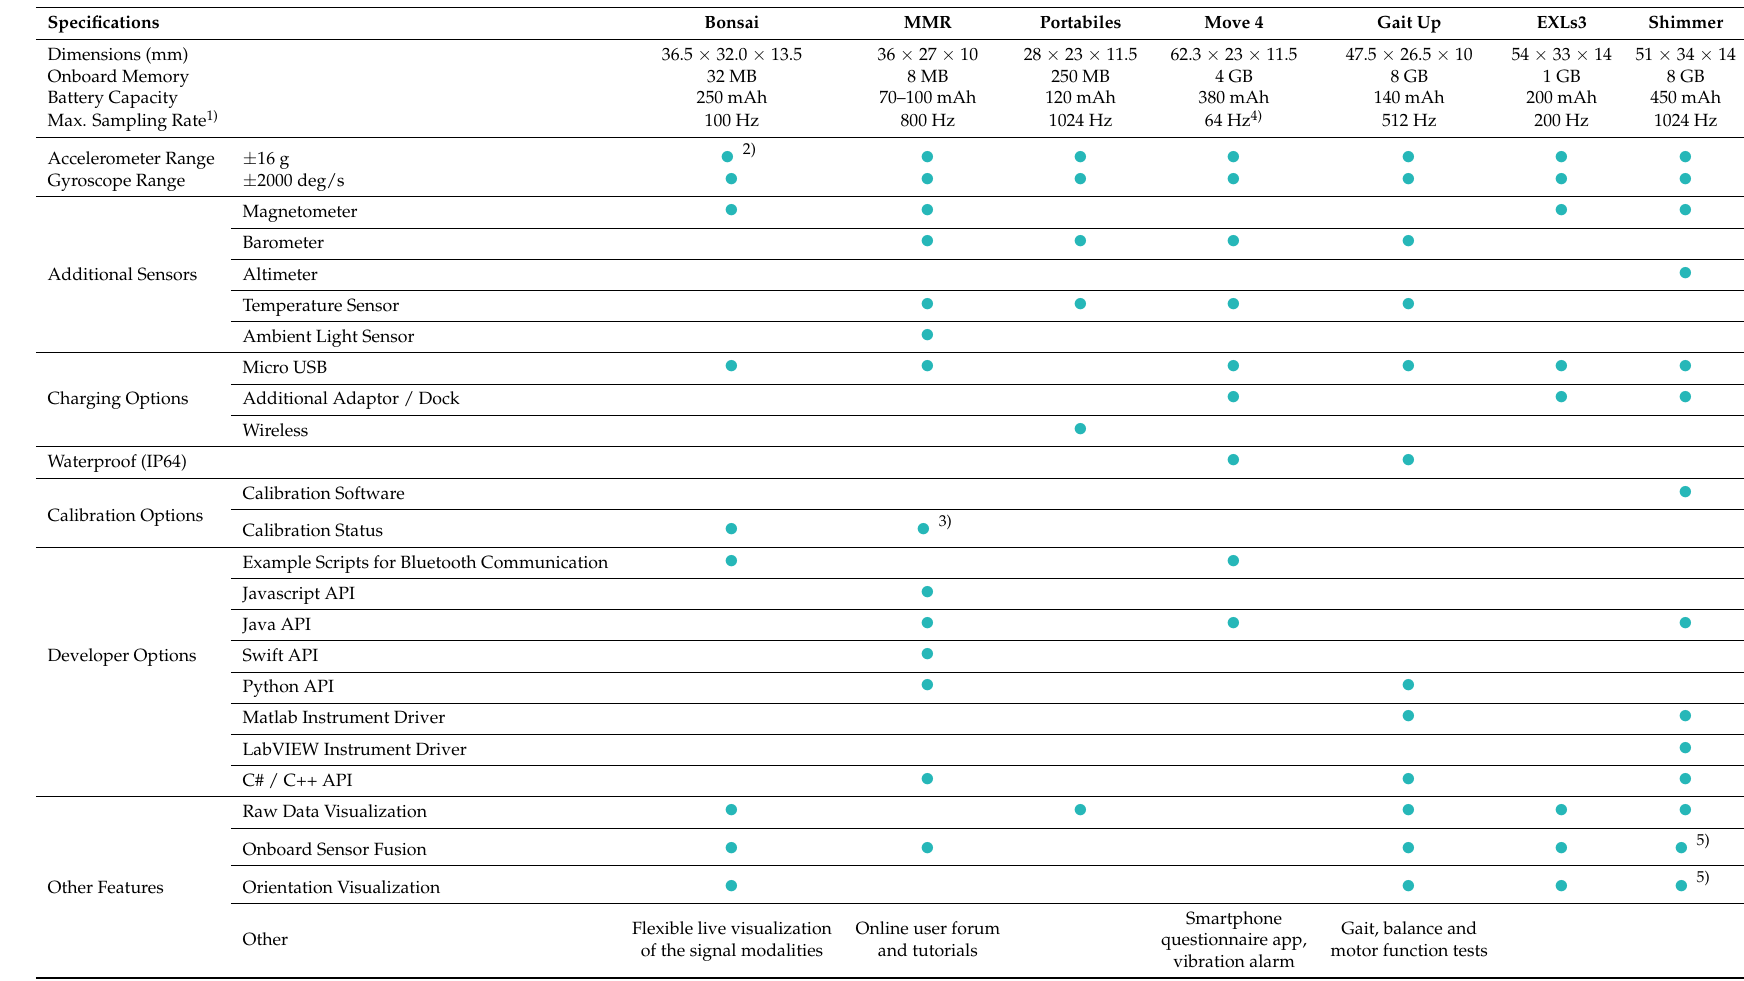
Table 6. IMU device